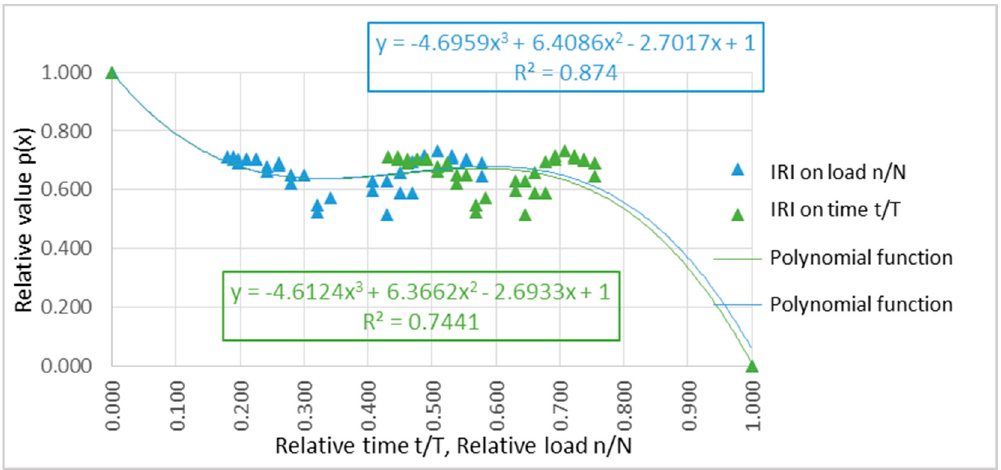
Figure 10. Degradation of the IRI depending on the time t/T and load n/N.